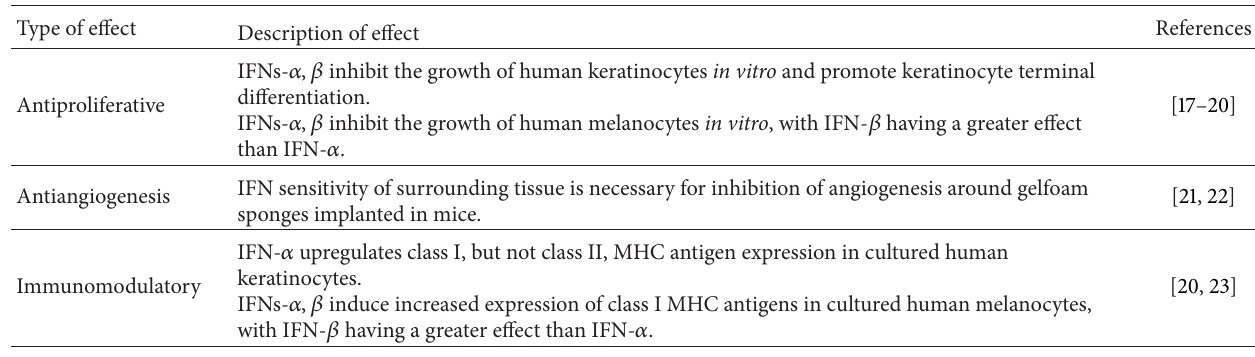
Table 1: Effect of type I Interferon on normal keratinocytes and